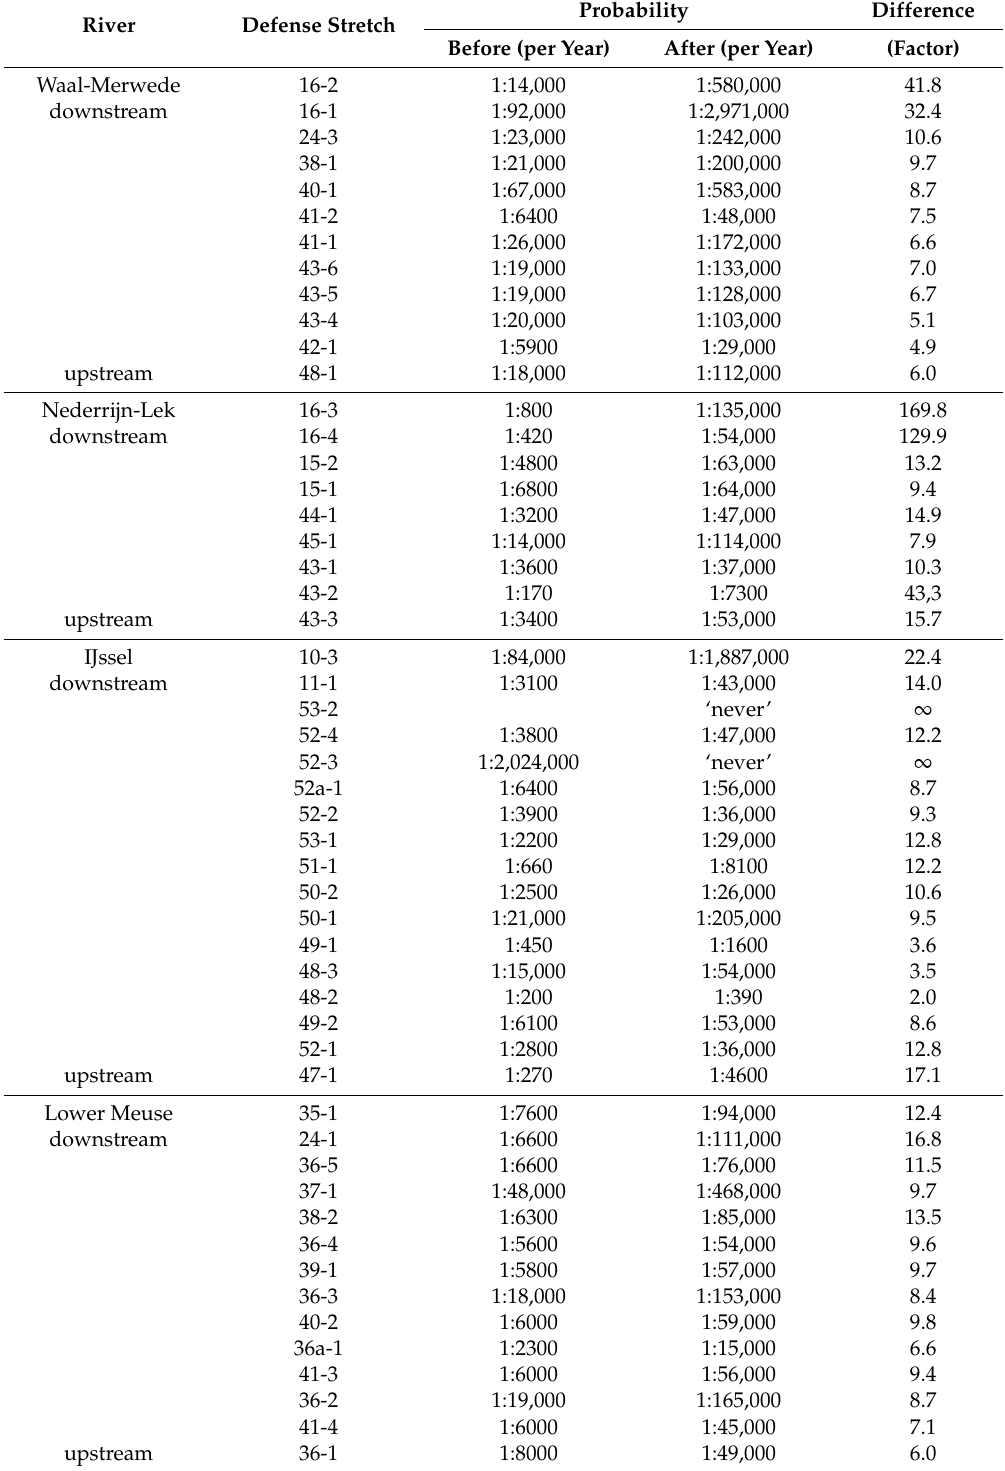
Table 2. Calculated probability of breaching per flood defense stretch, before and after lowering the flood water levels by 0.5 m, and difference between the two probabilities